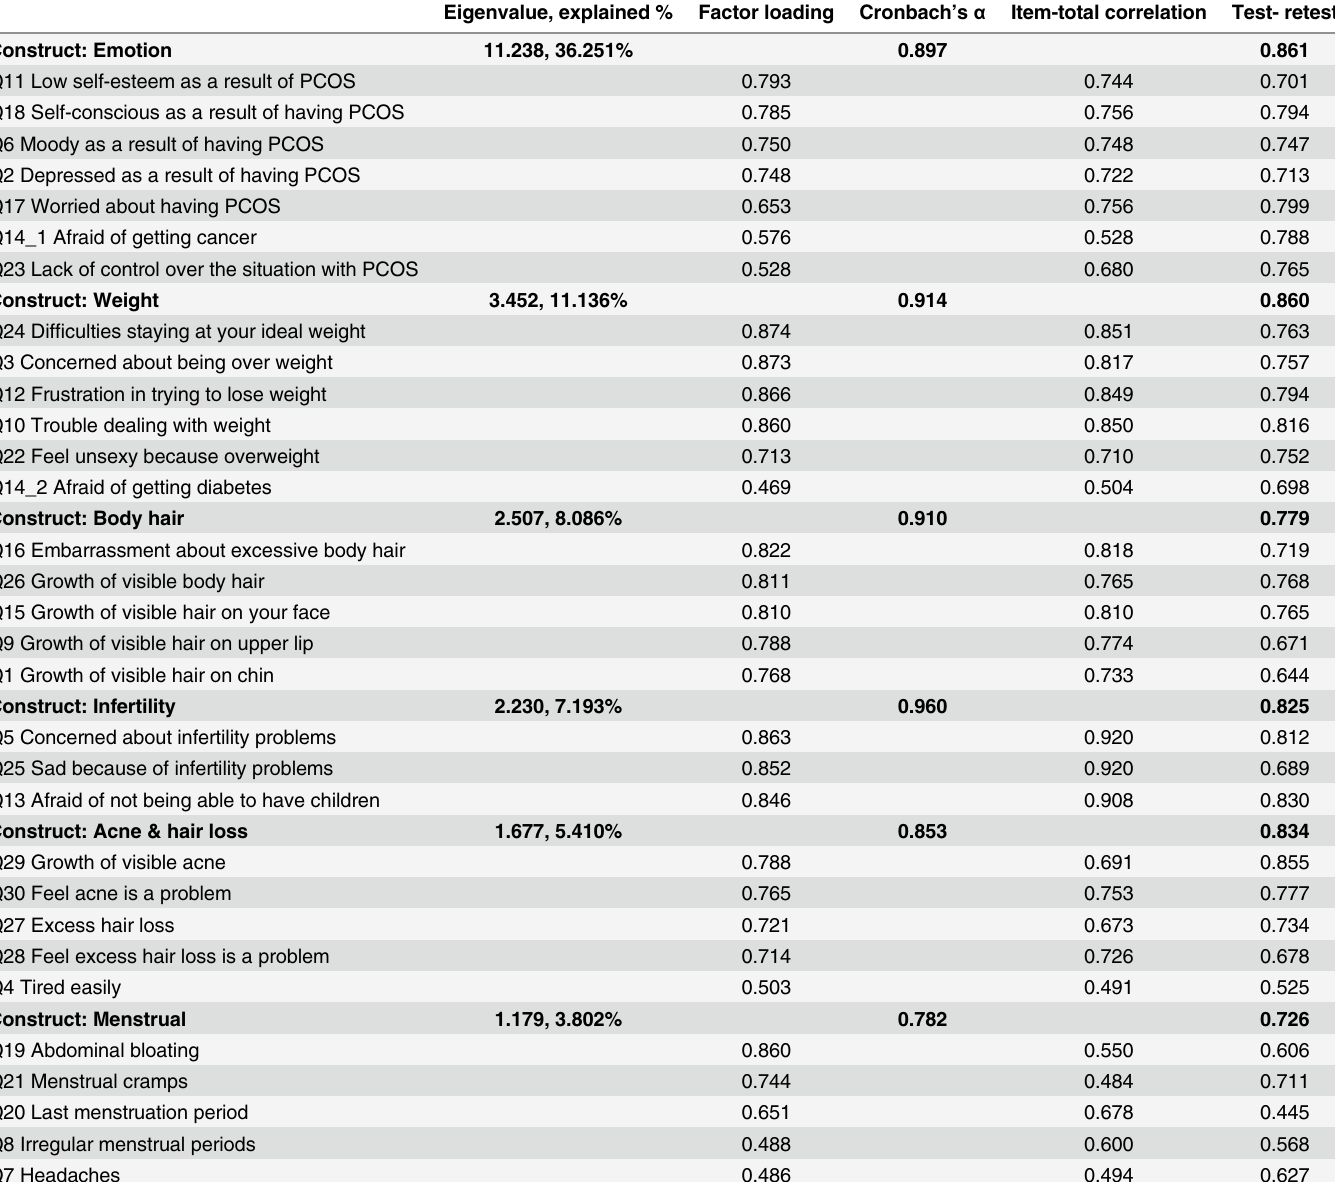
Table 3. Internal consistency, item-total correlation, and test-retest reliability. Note: Cronbach ’ s α for total score of PCOSQ = 0.939; values for con- structs are in bold